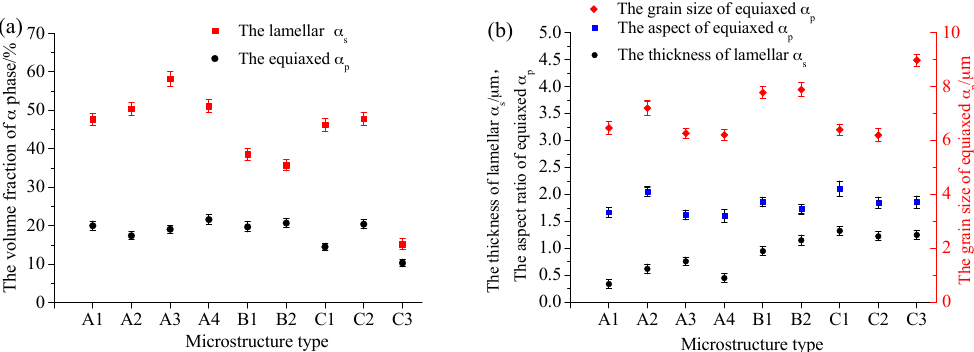
Figure 5. Measured microstructural characteristic parameters obtained microstructures in TA15 alloy: ( a ) volume fraction of α phase; ( b ) size of α phase.